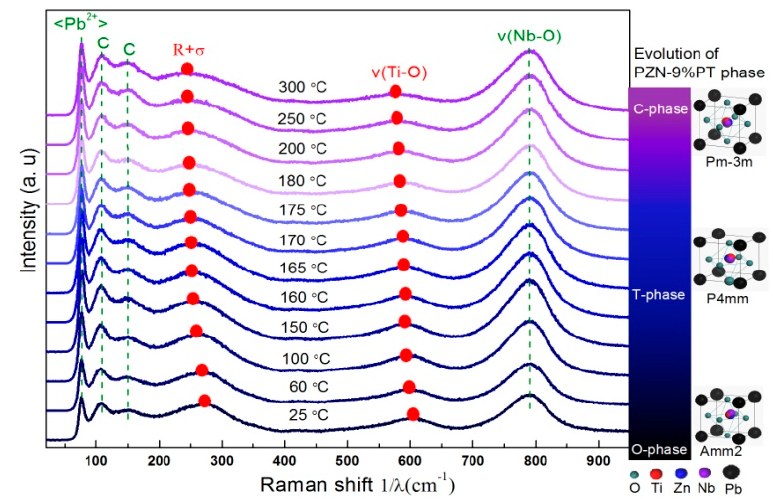
Figure 3. The temperature-dependent Raman spectra of PZN-9PT. Red solid circles show the shifts and intensity changes of the related Ti–O vibration peak. The right image shows a schematic of the structure evolution and corresponding atomic models.